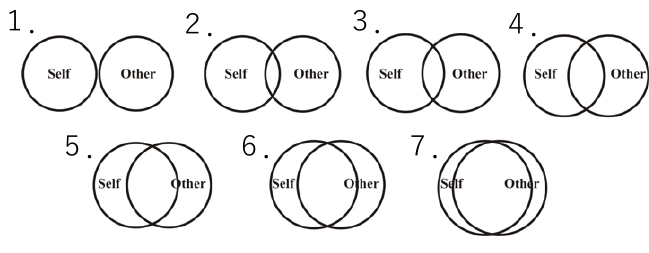
Figure 4. Representation of the IOS